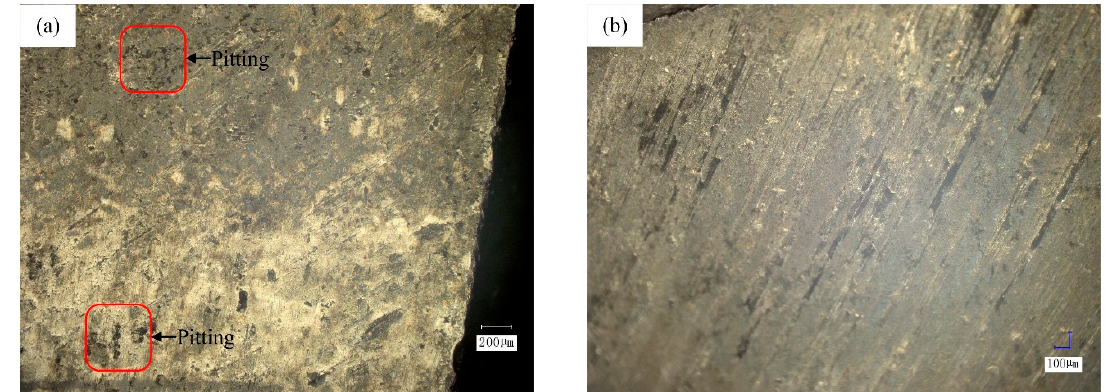
Figure 9. Typical morphology of gear 2 ‐ 2 tooth flank: ( a ) point (V8, H5) and ( b ) point (V6, H2).